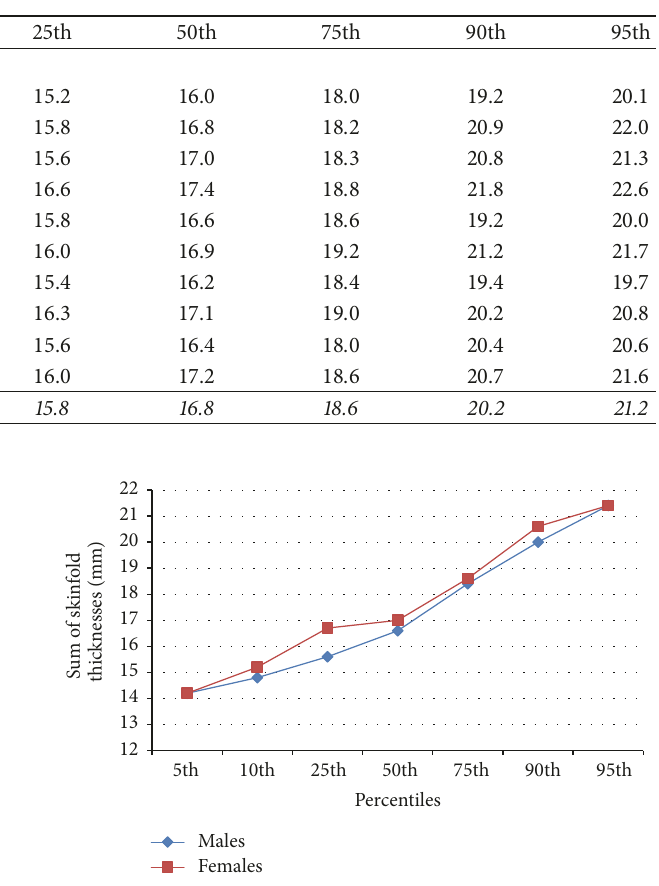
Table 5: Percentile distribution for the sum of skinfold measurements in the neonates.